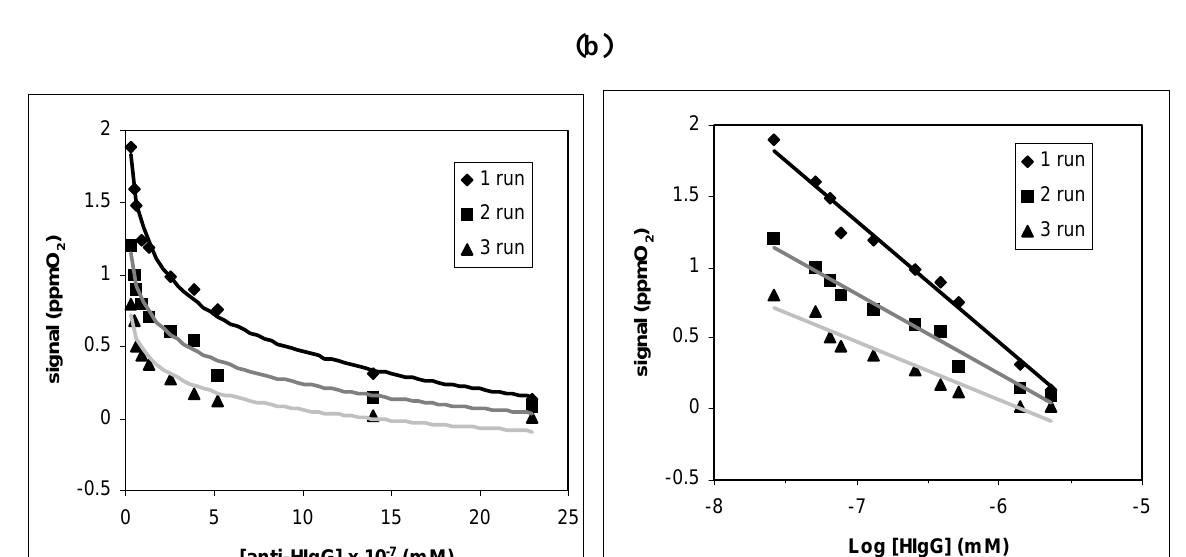
Figure 7. Reutilization of the immunosensor for anti-HIgG analysis after washing with glycine solution 0.1 M, at pH = 2 and MgCl Immobilon